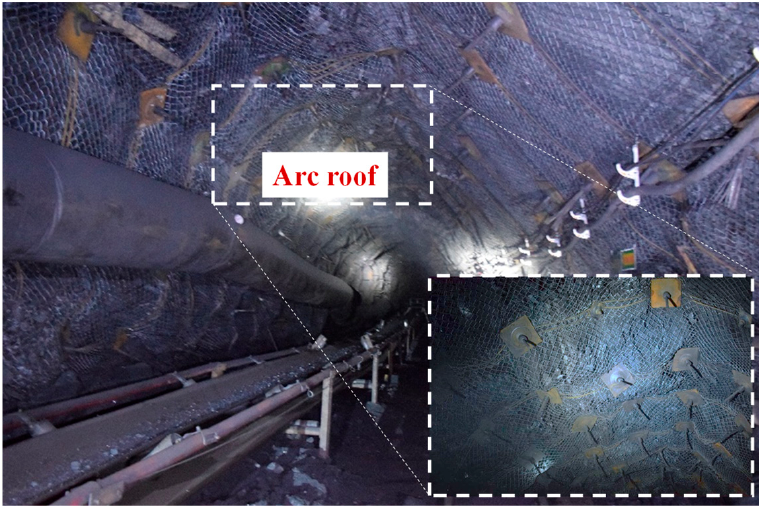
Figure 18. Maintenance and control effects of the roadway under the new